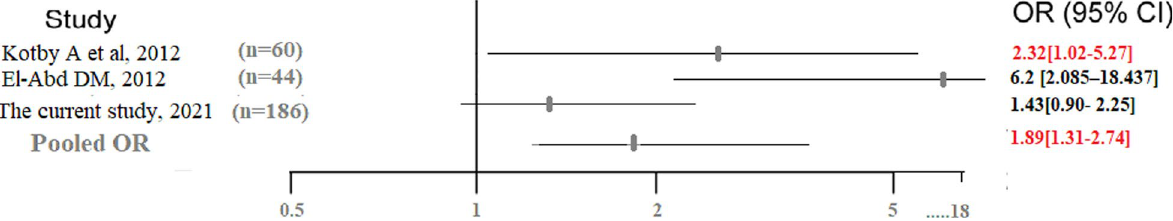
1.89, 95%CI 1.31–2.74, P 0.0004, P heterogeneity 0.001, I 2 = = = = =